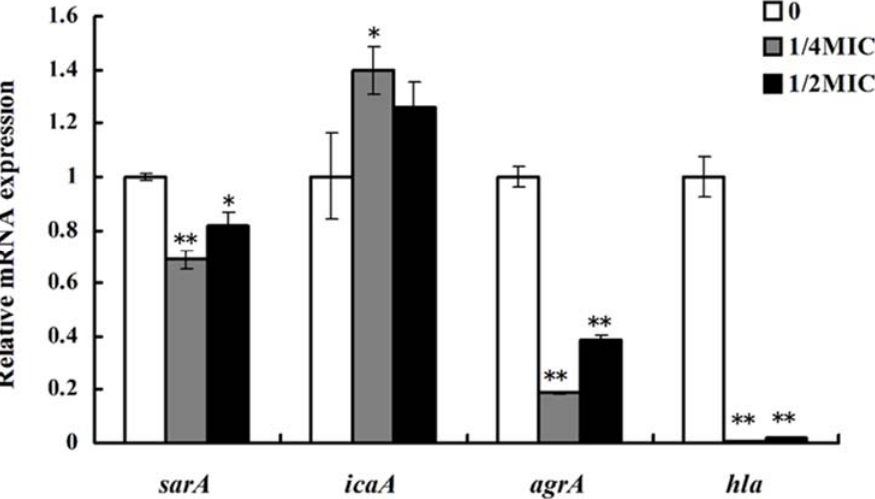
Figure 7. qRT-PCR results of 10-HDA’s effect on the transcription of biofilm- and virulence-related genes. * p < 0.05, ** p < 0.01.